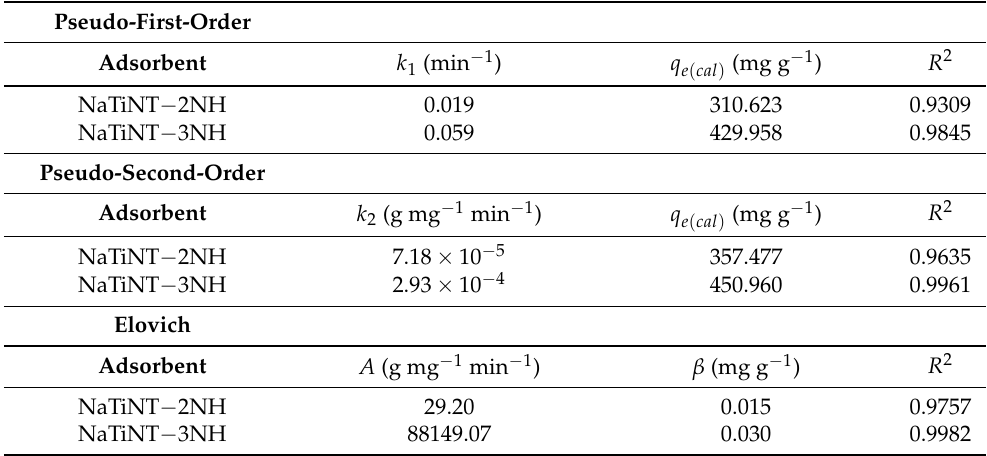
Table 2. Kinetic parameters obtained with the Pseudo-First-Order, Pseudo-Second-Order, and Elovich models for RB adsorption on NaTiNT − 2NH and NaTiNT − 3NH.